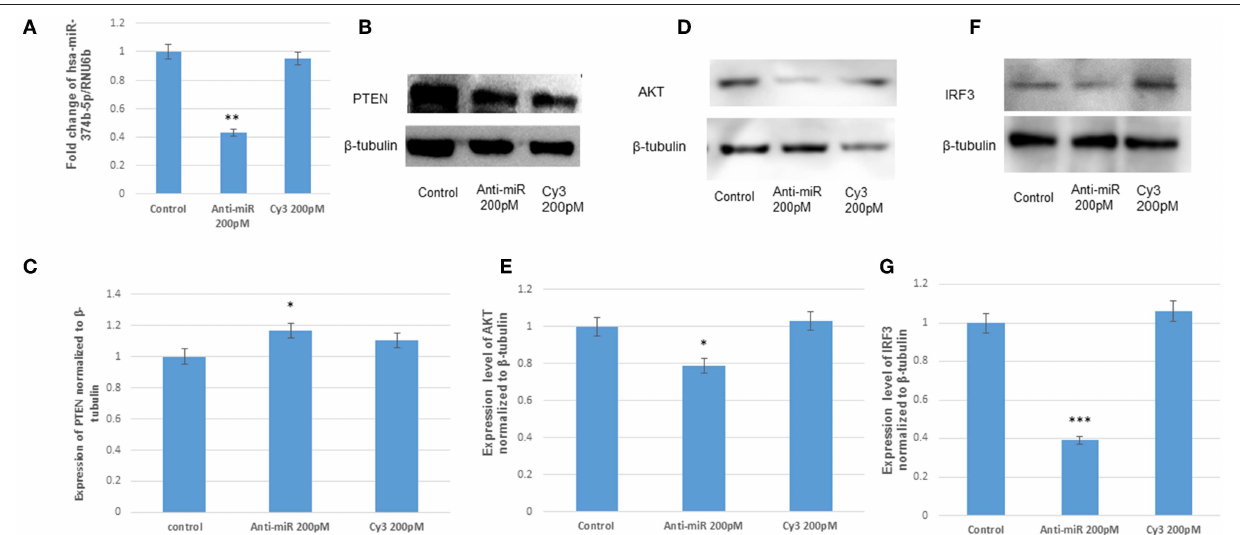
FIGURE 4 | The anti-miR-374b-5p rescues the expression of PTEN and suppresses the expression of AKT and IRF3. The knock down studies of hsa-miR-374b-5p (A) qRT-PCR knockdown of miR-374b-5p in human microglial cells by using inhibitors at 200 pmol conc. (B) The immuno blots showing the rescue of PTEN expression 48h post transfection. (C) The densitometry of PTEN. (D) The immuno blots shows the suppression of AKT by 20% during transfection. (E) Densitometry of AKT. (F) The immuno blots shows the suppression of IRF3 by 60% during transfection. (G) Densitometry of IRF3. The data are shown as mean ± S.E from three independent experiments ( n = 3 ). The fold change is significant where * denotes P < 0.05, ** denotes P < 0.01, *** denotes P < 0.001.